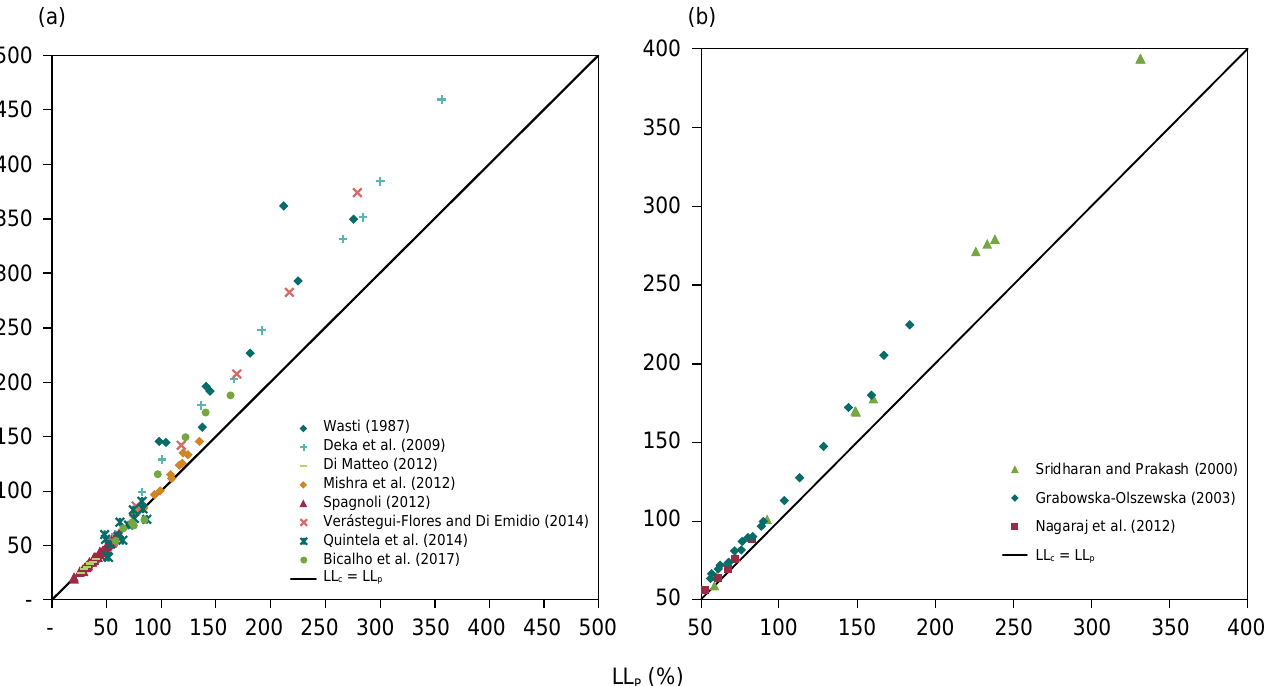
Figure 1. Experimental results: investigated soils in group B-01 (LL p -LL c-hard base ), n = 117 (a); soils investigated in group B-02 (LL p -LL c-soft base ), n = 67 (b).